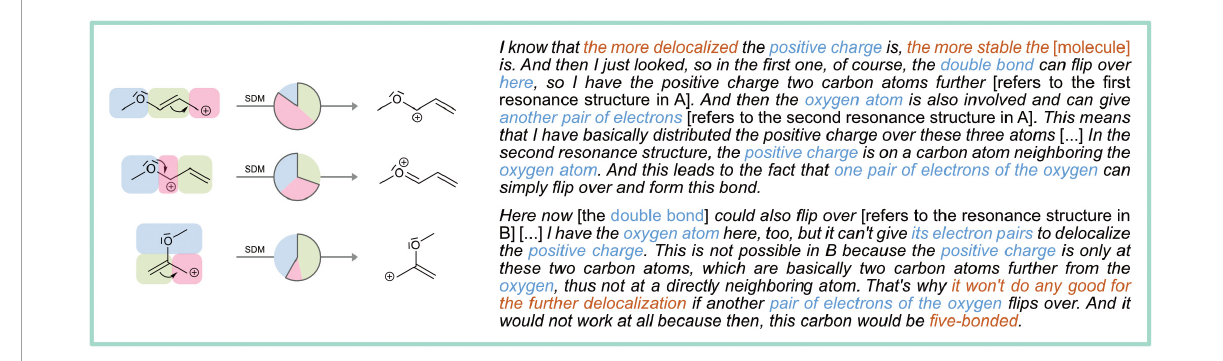
FIGURE14 Phil’s drawing moves, fixation duration rates on the structural features and drawing description for his drawings in reaction A and B. The green frame indicates the productivity of the resulting